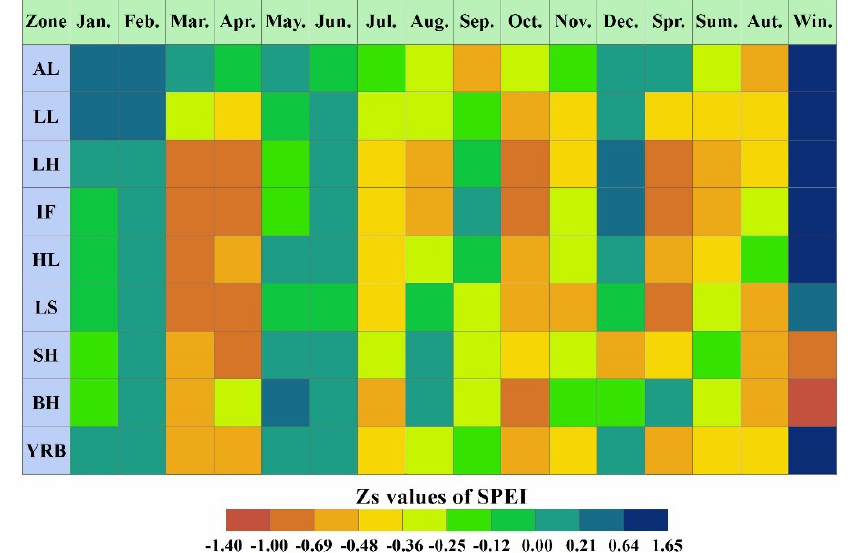
Figure 6. Z s values of SPEI in the YRB during 1961–2015.